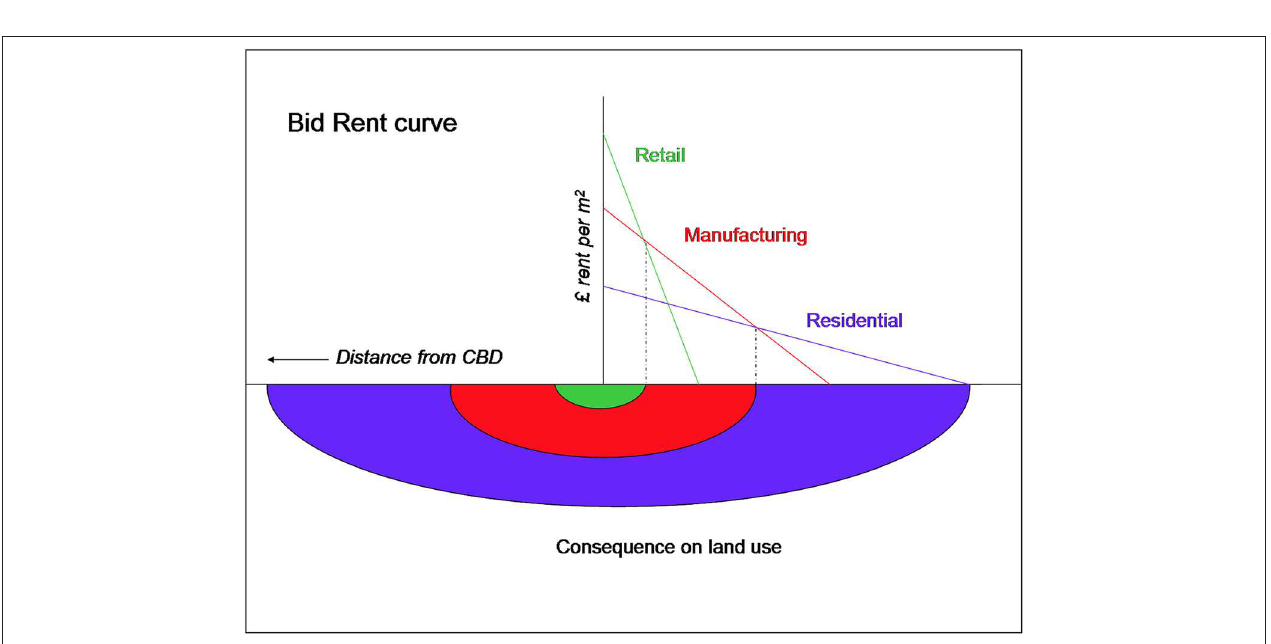
FIGURE 3 | Graphic illustration of Burgess’ concentric zone model. Nb: Zones 4 and 5 (Rubenstein, James M. The Cultural Landscape: An Introduction to Human Geography, 9th, © 2008. Reprinted by permission of Pearson Education, Inc. New York, New York).